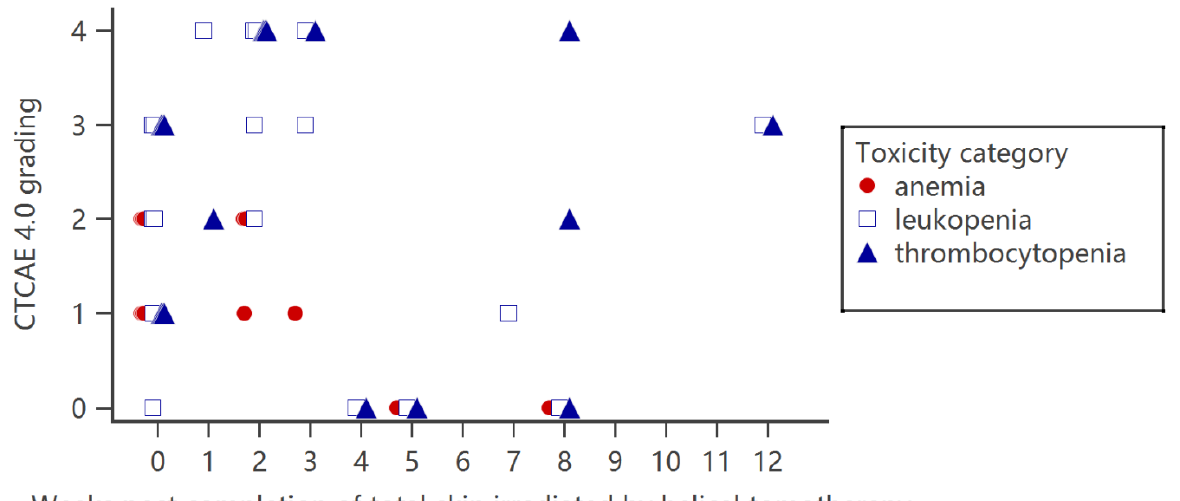
Figure 2. Hematopoietic toxicity severity and presentation time for patients who received total skin irradiation by helical tomotherapy. Each data point represents individual patient toxicity data re- ported in the articles. Table 3. Dose regimen, correlated bone/bone marrow dose evaluation, and hematopoietic toxicity for patients treated by helical arc radiotherapy of total skin (HEARTS) or other similar techniques.